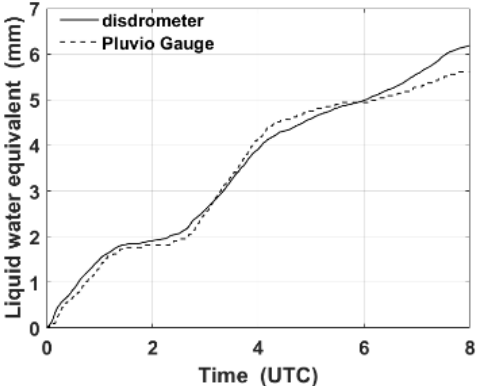
Figure 2. Comparison of liquid water equivalent snow accumulations computed using the density determination based on Parsivel 2 disdrometer measurements (Equation (2)) and that were directly measured by Pluvio 2 gauge for 19 March 2018 at YPO site. Table 1. Meteorological conditions on 19 March 2018. Listed are the times, temperature, humidity, wind speed (here abbreviated as WS), and wind direction (WD).